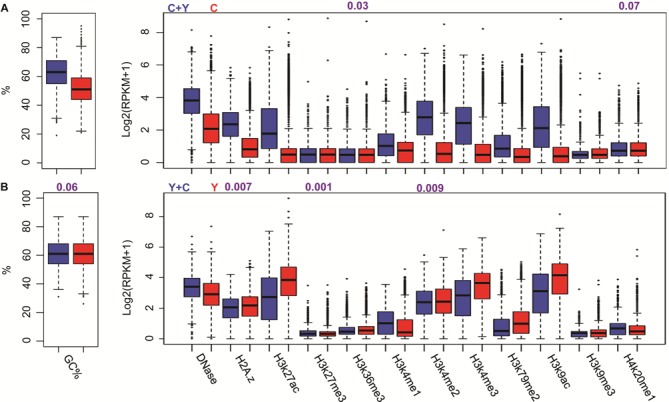
Comparison of chromatin feature profiles (A) between CTCF–YY1 co-occupying (C + Y, blue) and CTCF-only binding regions (C, red) and (B) between YY1-CTCF (Y + C, blue) and YY1-only (Y, red) binding regions in the K562 cell line. All tests reached P-values < 1.0E-5, unless values are shown in figures (numbers in purple).